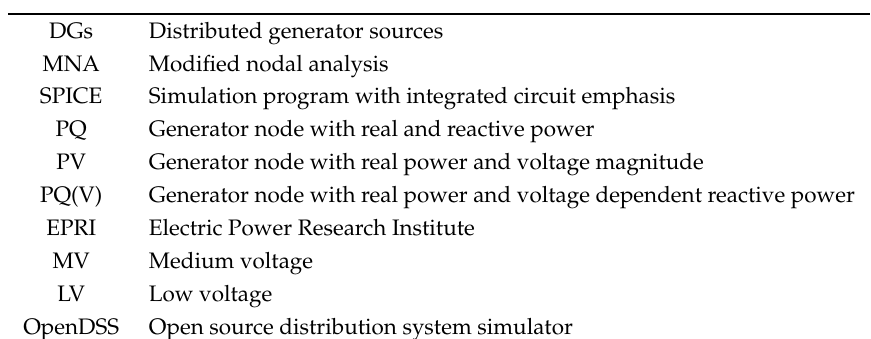
Table 1. List of